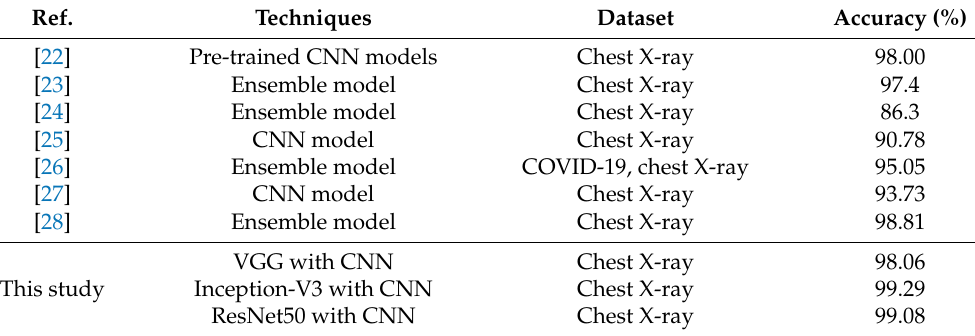
Table 6. Performance comparison with other